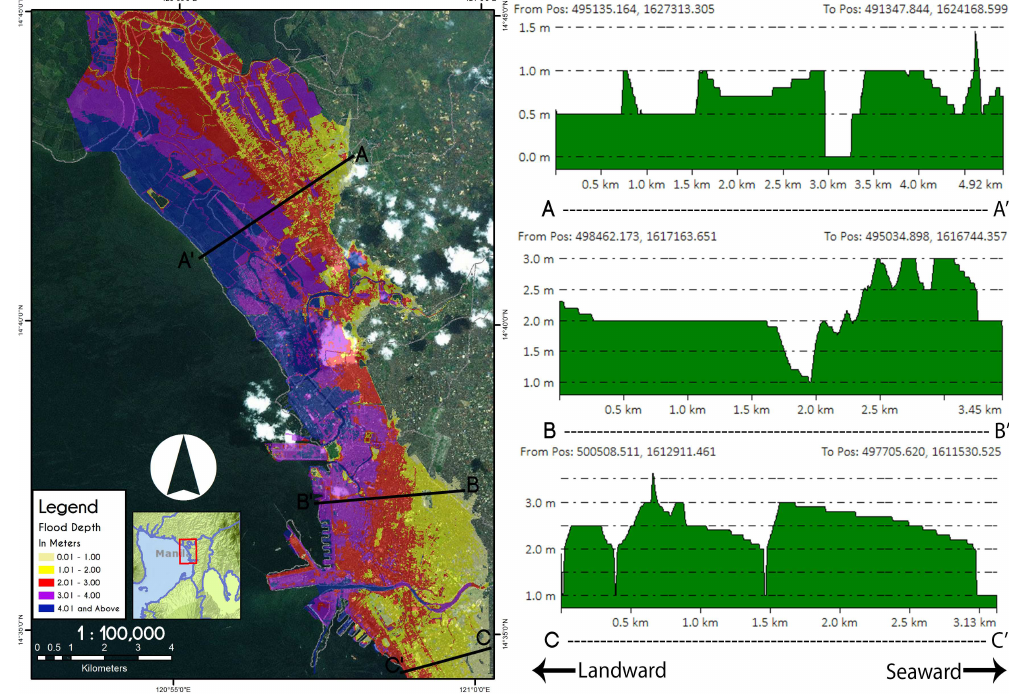
Figure 5. Manila inundation map with topographic elevation profiles at the marked transects (variable y axis scale to clearly display the local variation in